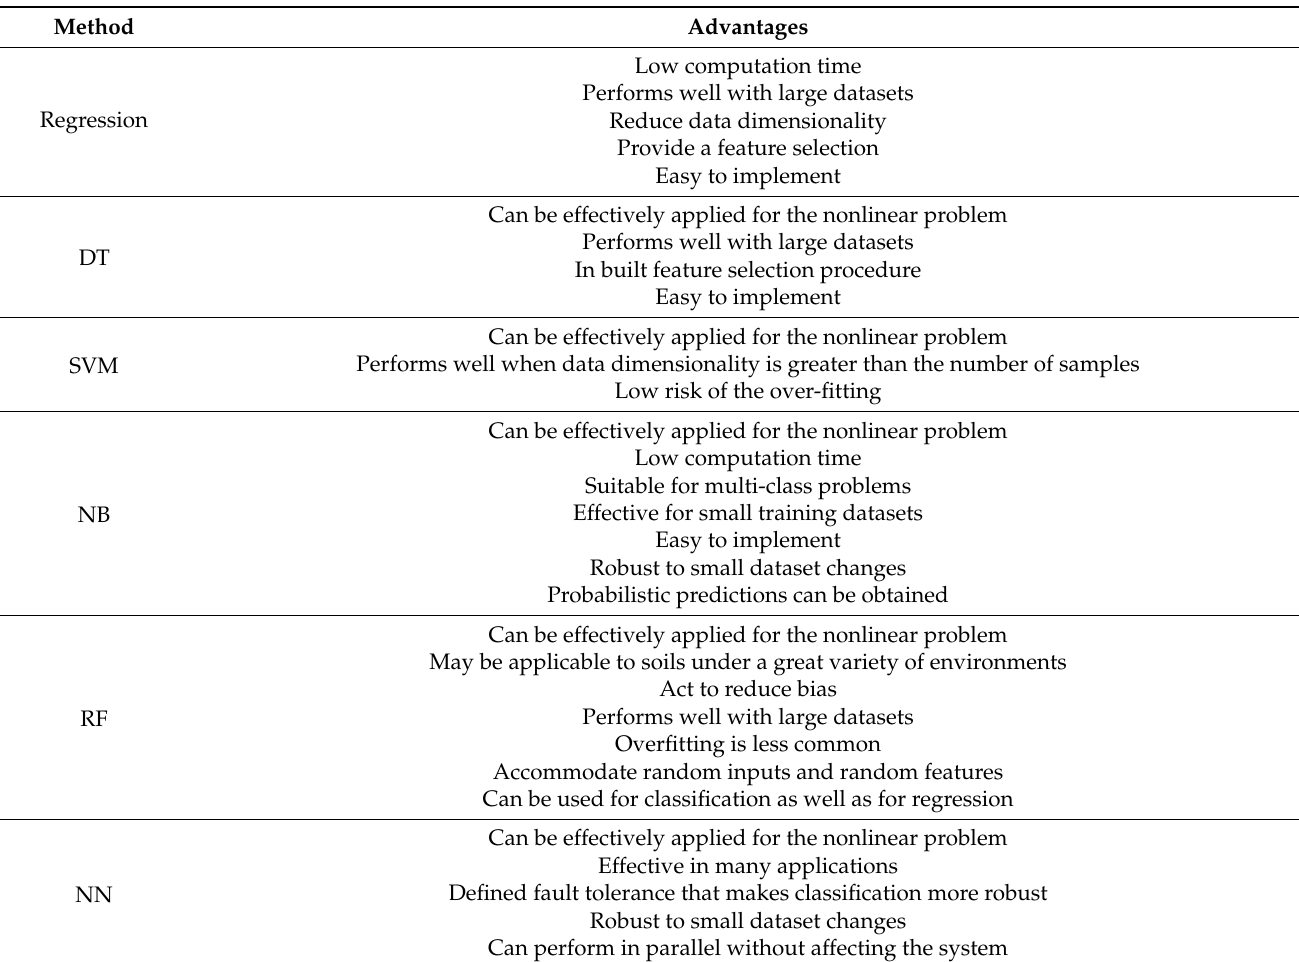
Table 2. Comparison of advantages of machine learning techniques.